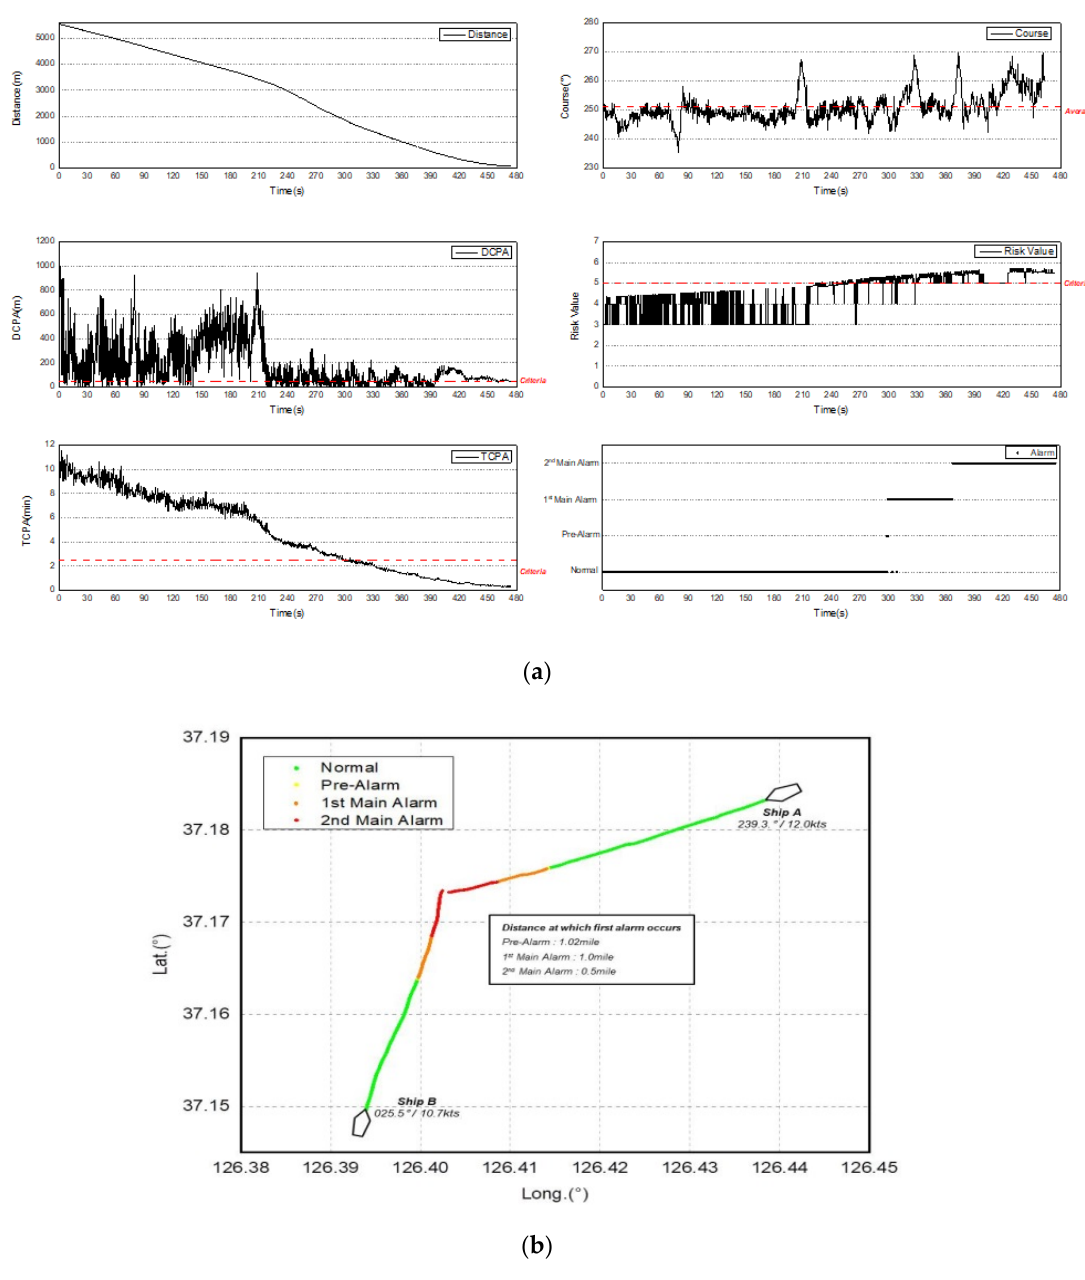
Figure 13. ( a ) Experimental results; ( b ) track and alarm analysis for.